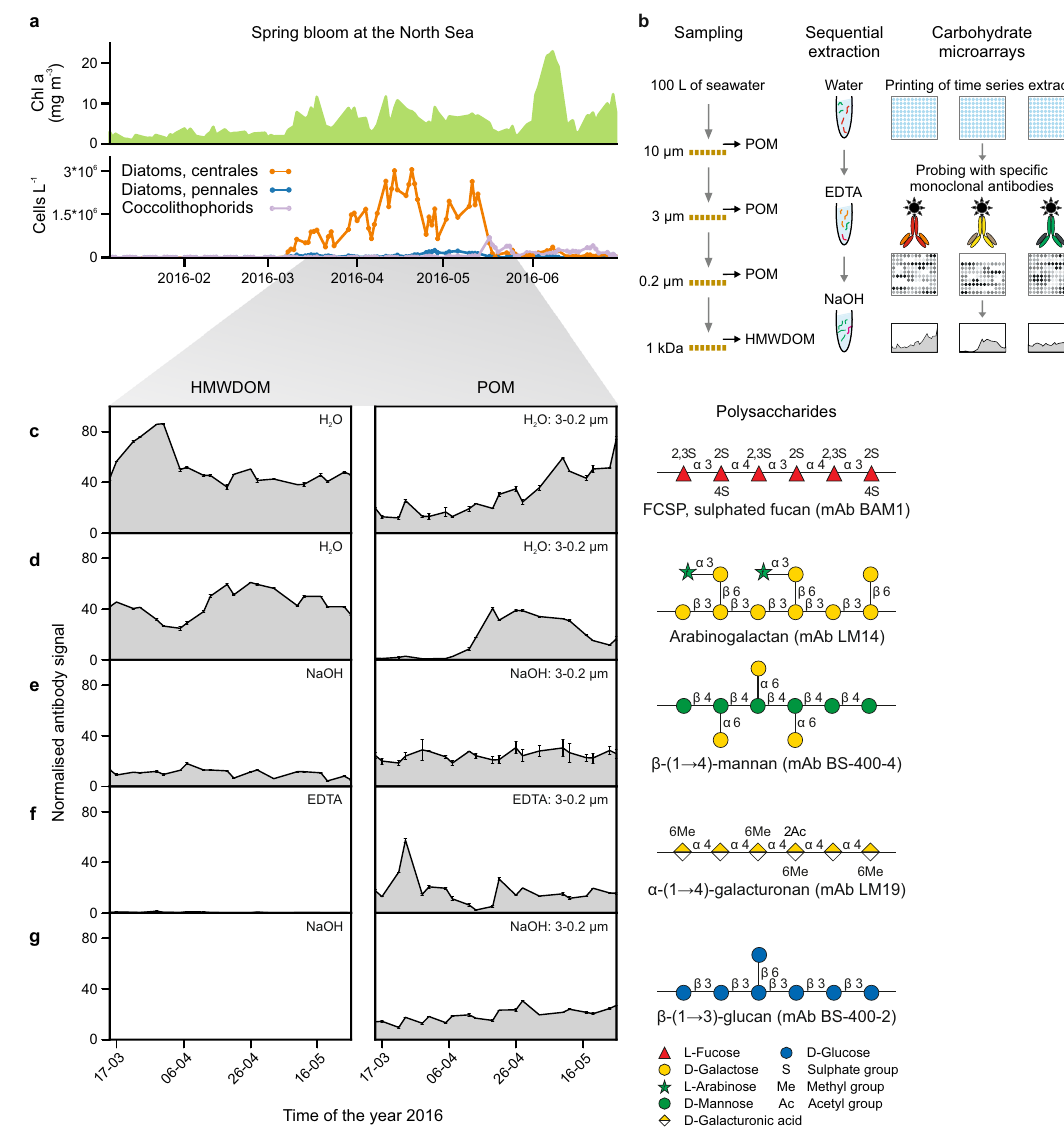
Fig. 1 Different polysaccharide structures are present in high molecular weight dissolved organic matter (HMWDOM) and particulate organic matter (POM) and show fl uctuations in their abundance during the diatom bloom. a Chlorophyll a (Chl a) concentrations and abundances of the major microalgae taxa detected at our sampling site (54 ˚ 11.3 ′ N, 7 ˚ 54.0 ′ E) from January to June 2016. b Scheme of the sampling and carbohydrate microarray analysis. c – g Representative examples of fi ve selected polysaccharides, complete microarray data set is shown in Supplementary Fig. 5. On the left, plots show the relative abundance of polysaccharide epitopes (antibody signal intensity, y axis) detected in HMWDOM and POM during the bloom (21 sampling dates, x axis). Spot signal intensities for each extract (each extract was represented by 4 spots in the array) against each probe were quanti fi ed and the highest mean signal value in the data set for HMWDOM and for POM was set to 100 and all other values were normalised accordingly. Data are mean values, n = 4 spots per extract. The temporal dynamics but not the absolute number should be compared between HMWDOM and POM pools as they required independent normalisation, since they required different sampling strategies. At the right, sketch of polysaccharide structures that the corresponding monoclonal antibodies (mAbs), which are depicted in parentheses, bind to. HMWDOM, between 0.2 µ m and 1 kDa. Error bars in c – g represent ± standard